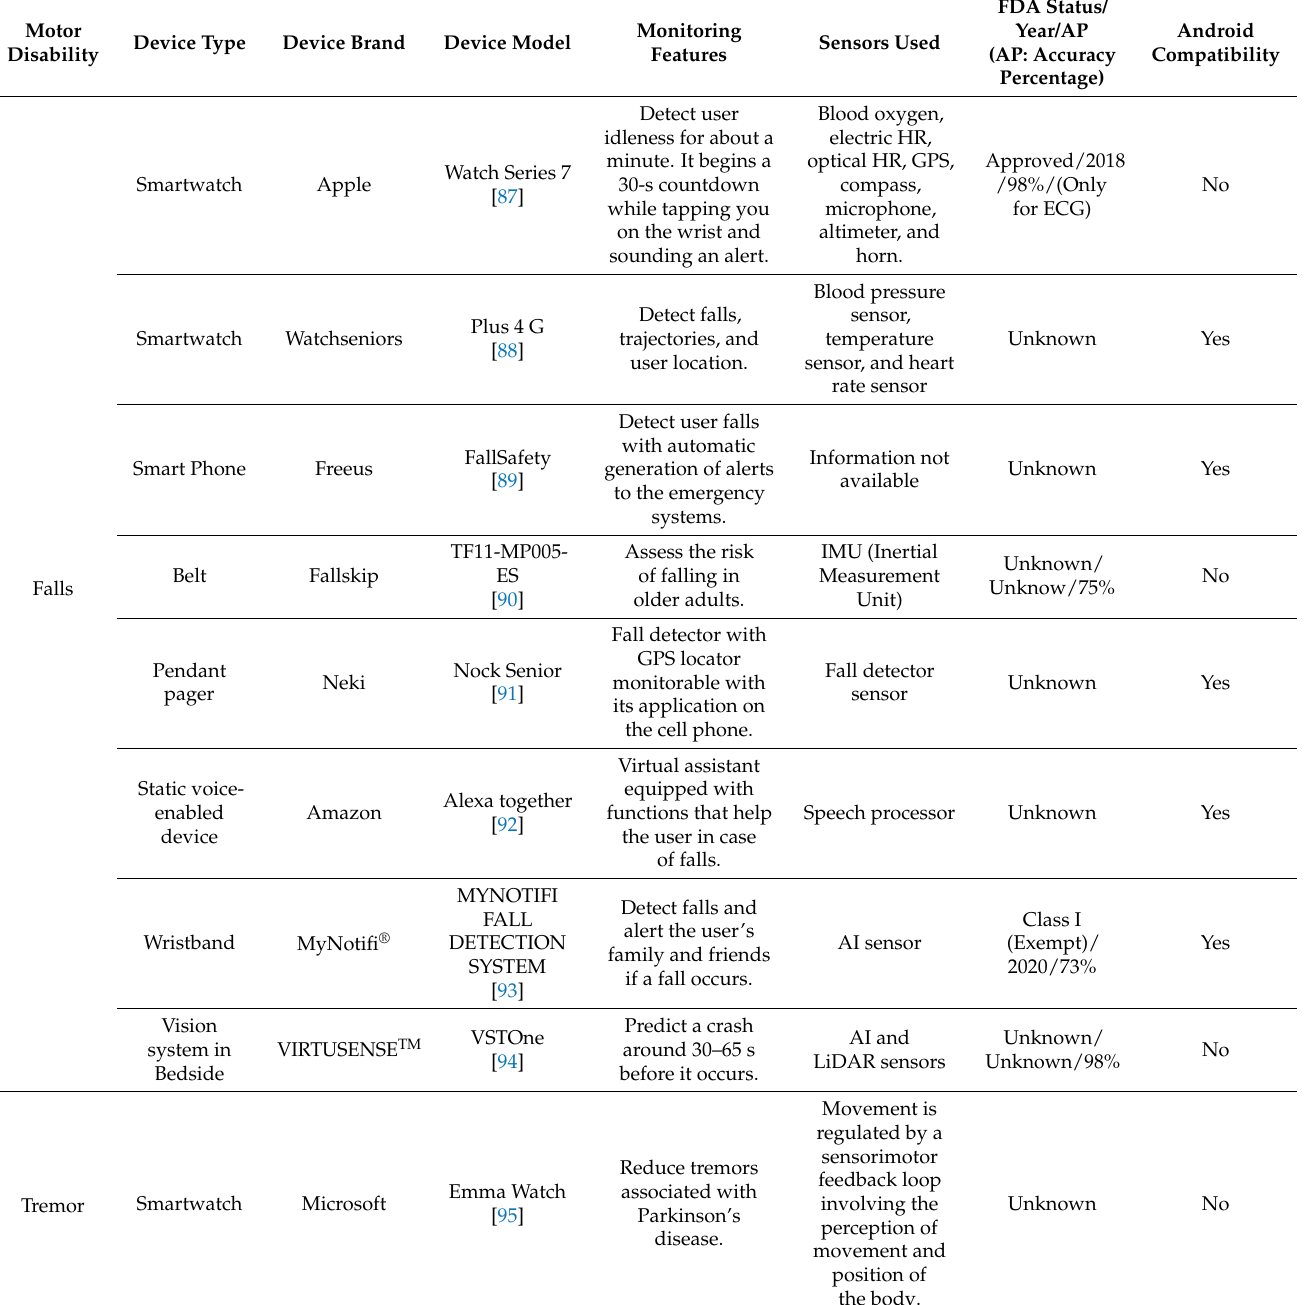
Table 4. Commercial Wearable Devices for Monitoring NDD-Related Motor